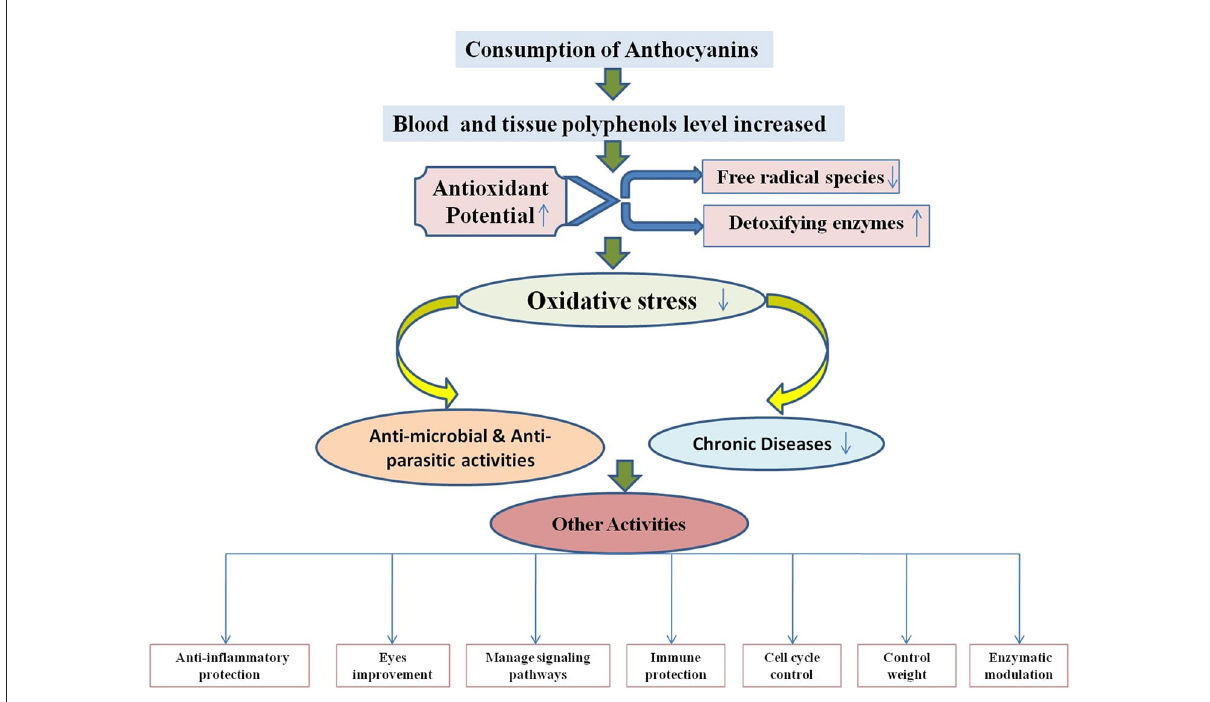
FIGURE5 Mechanism of antioxidant potential of anthocyanins and reduction of chronic diseases, microbial, and parasitic